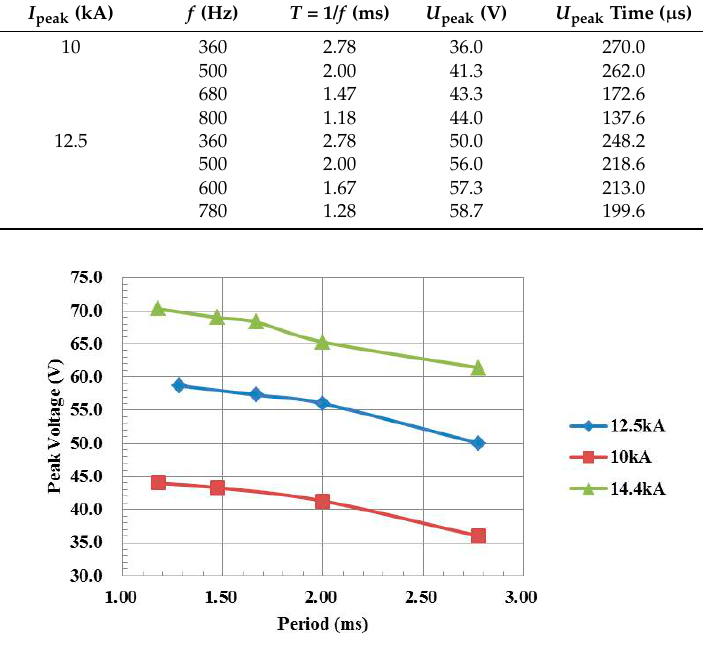
Figure 3. Peak value of arc voltage in different frequency.